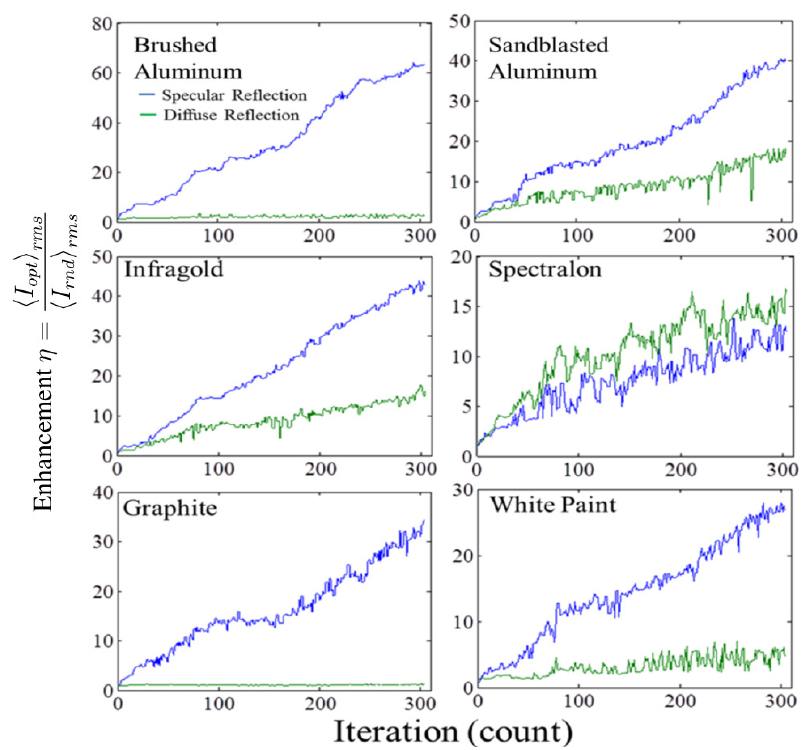
Figure 13. Enhancement comparisons of specular and diffuse regions of reflection. Enhancement is plotted after each optimization with the CCD placed in the specular region at 45 ◦ from the reflector surface normal (blue). Specular is defined as a reflection angle of 45 ◦ ± 0.5 ◦ from the surface normal. Diffuse is defined as 15 ◦ off